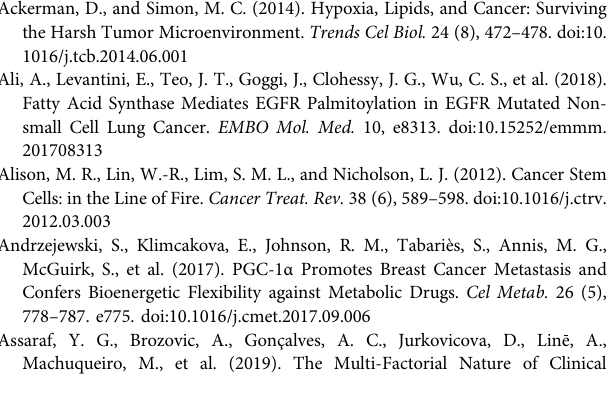
Frontiers in Cell and Developmental Biology |